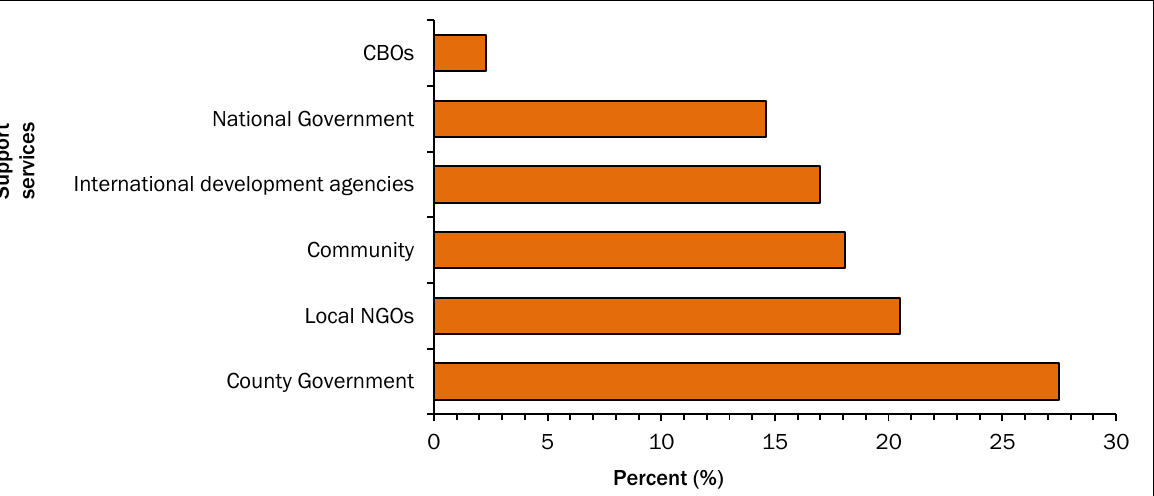
Figure 3. Perception of Actors on the Level of Support Services Offered by Varied Stakeholders in the Camel Milk Value